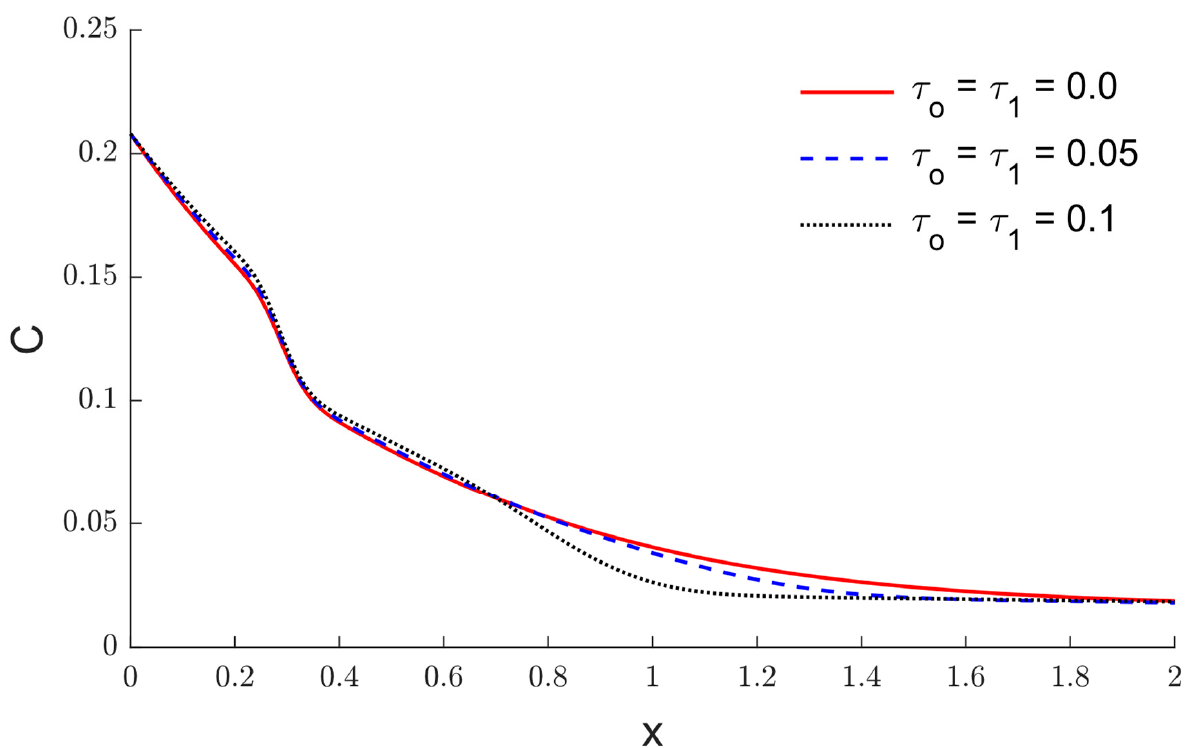
Figure 8. The impact of thermal relaxation times τ o , τ 1 in the concentration variation u via the distance x when K n = 0.5.